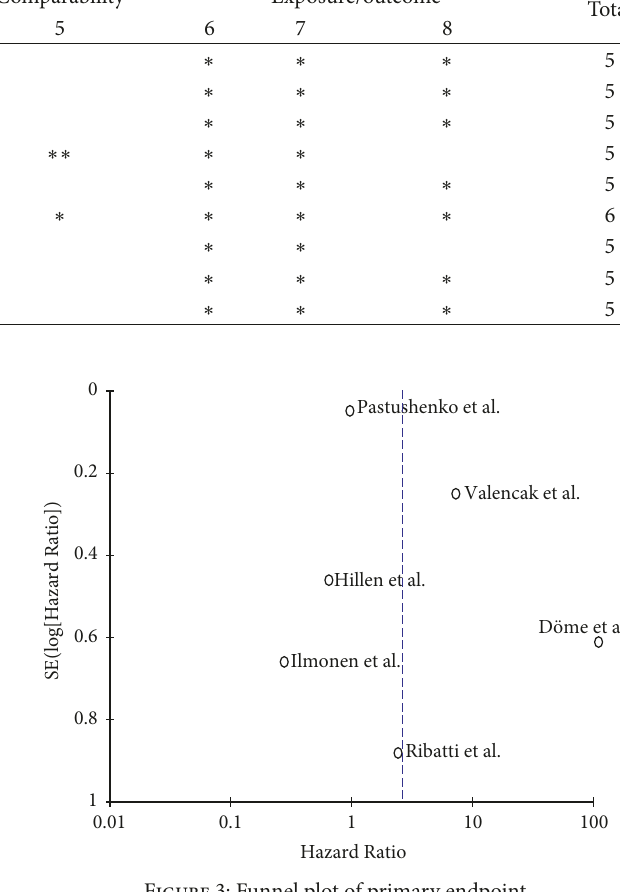
Figure 3: Funnel plot of primary